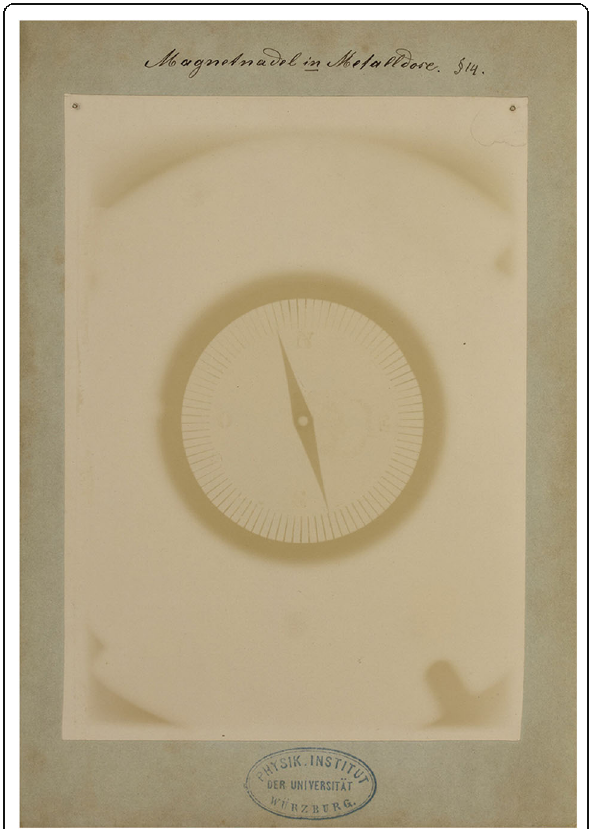
Fig. 10 Roentgen was aware of the existence of optical birefringence (a crystal is said to be optically birefringent, or double refracting, if its refractive index depends on the polarization and propagation direction of the light with respect to the crystal orientation; a necessary condition is that the crystal is anisotropic; many such birefringent crystals, e.g. calcite and quartz, have a single axis of symmetry). Roentgen ‘ s experiments with prisms to observe refraction of X- rays failed, because, as later was measured, the index of refraction of X-rays is many orders of magnitude smaller than that of visible light. Therefore, the likelihood of observing double refraction in birefringent materials would also have been negligible (even if he had been able to realize the experimental conditions as used for visual light experiments, which he wasn ’ t). Nevertheless he may have wondered if for X-rays the transmission (and not the refraction) was dependent on the crystal orientation with respect to the beam direction. This would explain why he compared the transmission parallel (//) to the symmetry axis of the birefringent crystals ‘ Kalkspath ’ and ‘ Quarz ’ with that in a direction perpendicular ( ⊥ ) to it. As we now know, the attenuation (and thus the transmission) of X-rays is determined by the atomic number Z, the density and the thickness of the attenuating material, so here no effect was to be expected either. Manually written legend on the photographic paper: ‘ Glas, Aluminium, Quarz ⊥ , Quarz //, Kalkspath ⊥ , Kalkspath // ’ (glass, aluminum, quartz ⊥ , quartz //, calcite ⊥ , calcite //). Paragraph referral: § 3 and §